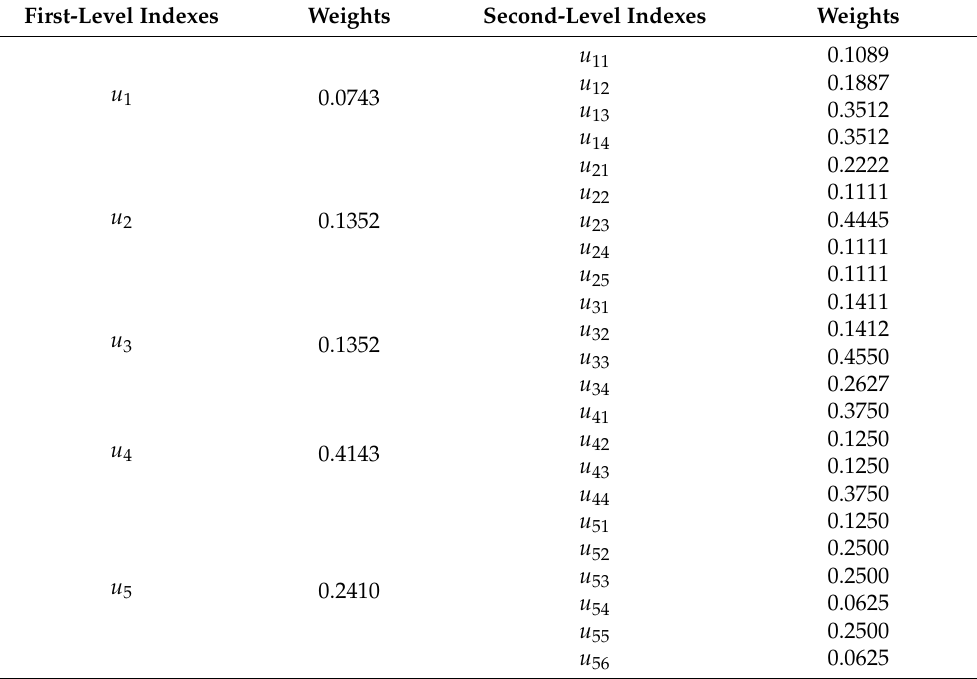
Table 8. Weights of passenger risk assessment